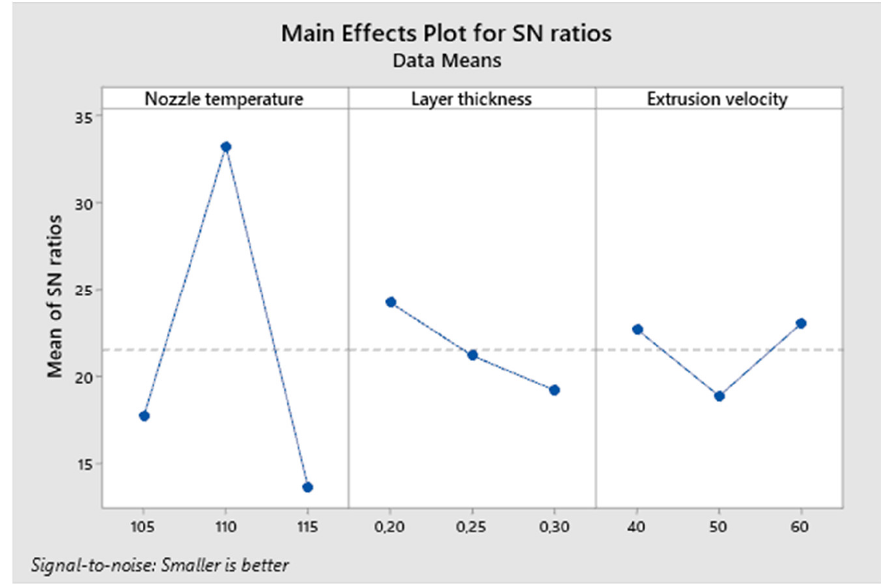
Figure 2. Main effects plot for S/N regarding part’s width accuracy. Table 6. ANOVA results for part’s height